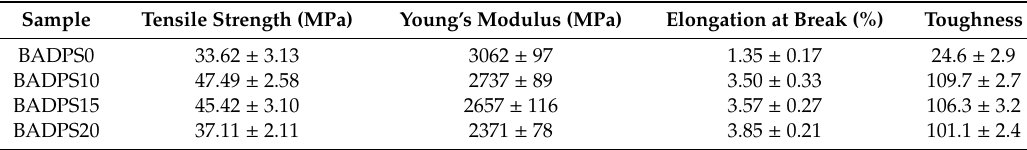
Table 1. Mechanical properties of the di ff erent unsaturated polyester resin (UPRs).